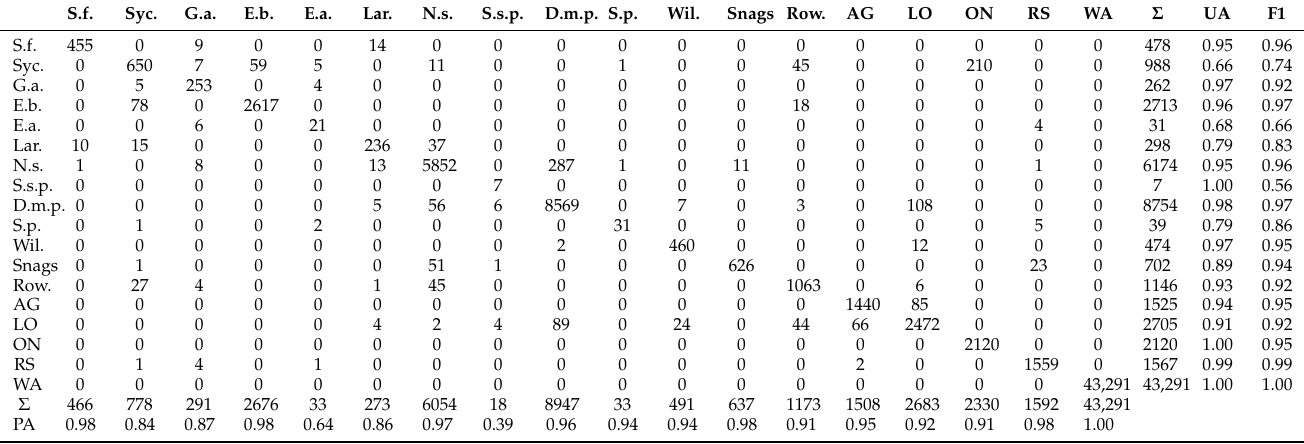
Table A2. Error matrix of obtained PlanetScope, with topographic features and Random Forest classification results. S.f.—silver fir ( Abies alba ); Syc.—sycamore ( Acer pseudoplatanus ); G.a.—grey alder ( Alnus incana ); E.b.—European beech ( Fagus sylvatica ); E.a.—European ash ( Fraxinus ex- celsior ); Lar.—larch ( Larix spp.); N.s.—Norway spruce ( Picea abies ); S.s.p.—Swiss stone pine ( Pinus cembra ); D.m.p.—dwarf mountain pine ( Pinus mugo ); S.p.—Scots pine ( Pinus sylvestris